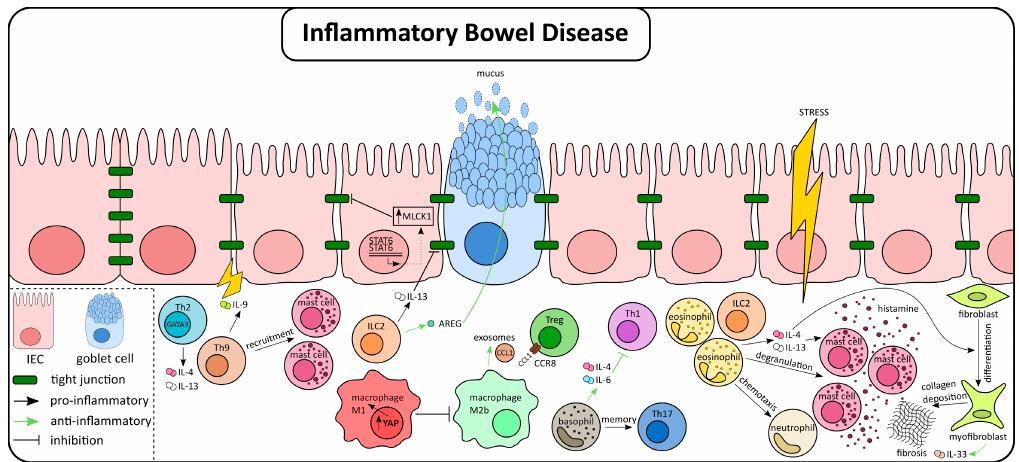
Figure 2. Schematic representation of IECs and immune cell crosstalk, mediated by type 2 cytokines, during inflammatory bowel disease. Dual effects of type 2 cytokines and effector cells during intestinal inflammation. CCL1, C-C chemokine ligand 1; CCR8, C-C chemokine receptor type 8; GATA 3, GATA binding protein 3; MLCK1, myosin light chain kinase 1; STAT, Signal transducer and activator of transcription; Treg, T helper cell; YAP, Yes-associated protein.